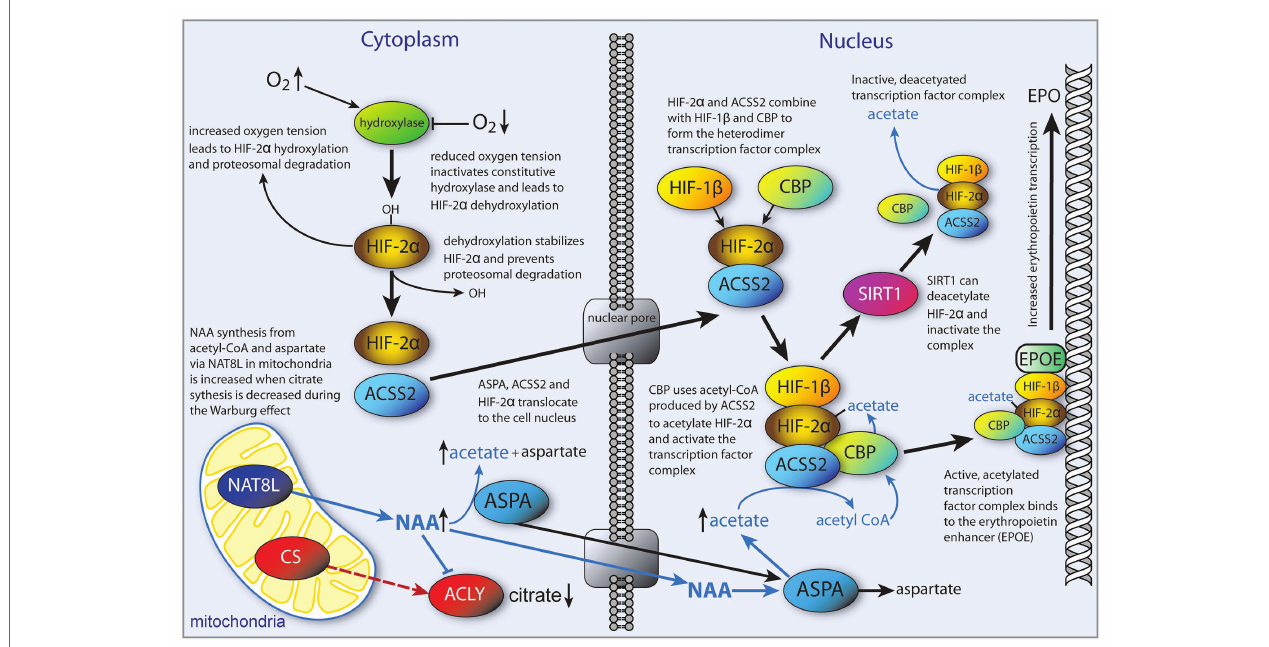
FIGURE 4 | Hypothesized role of NAA in cancer cells as an alternative source of acetyl-CoA for specific transcription factor acetylation in place of citrate. We propose that some transcription factors use the NAT8L-ASPA-ACSS2 pathway (“NAA pathway”) preferentially over the citrate-ACLY pathway. Activation of the hypoxia inducible factor-2 alpha (HIF-2 α ) transcription factor during hypoxia is shown as an example. Citrate synthesis is reduced due to the Warburg effect (possibly by direct NAA inhibition of ACLY) and NAA can act as an alternative acetyl-CoA source by the sequential actions of ASPA and ACSS2 (orange pathway). Both ASPA and ACSS2 have been shown to shuttle between the cytoplasm and nucleus. This general mechanism could be involved in a number of transcription factor signaling pathways. For example, transcription factor EB (TFEB), which controls autophagy, is responsive to NAA. See figure and text for additional details. ACLY, ATP citrate lyase; ACSS2, acyl-CoA short chain synthetase family member 2; ASPA, aspartoacylase; CBP, CREB binding protein (acetyltransferase); CS, citrate synthase; EPO, erythropoietin gene; EPOE, erythropoietin enhancer; HIF, hypoxia inducible factor; NAA, N-acetylaspartate; NAT8L, aspartate N-acetyltransferase (NAA synthase); and SIRT1, sirtuin-1 (deacetylase). Figure adapted from Jaworski et al.